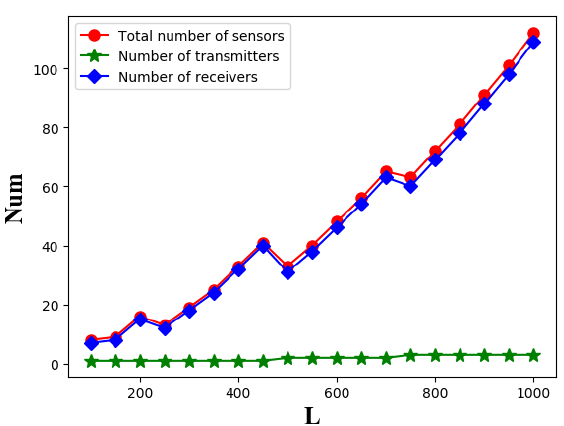
Figure 25. The relationship between the line barrier length L and the number of sensors .